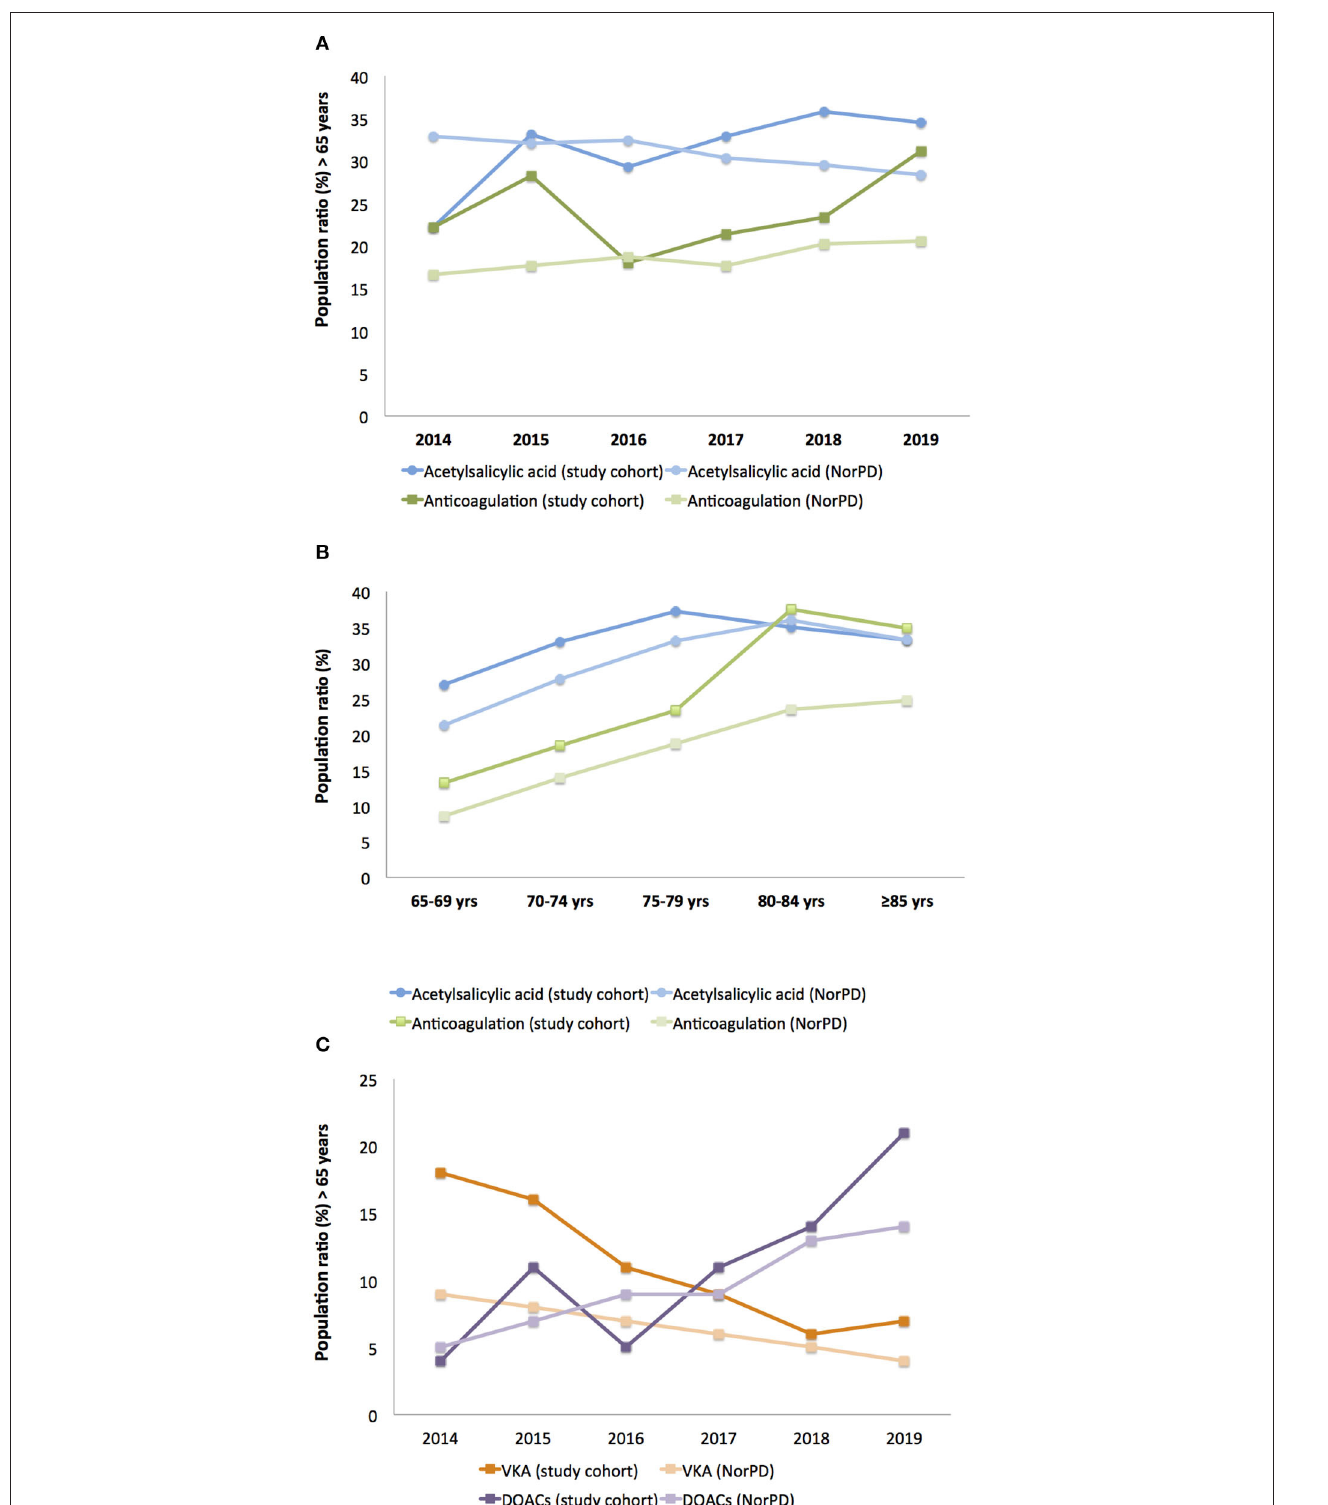
FIGURE 1 | Antithrombotic therapy in study patients compared to the general Norwegian population. (A) Use of acetylsalicylic acid and anticoagulation, (B) use of acetylsalicylic acid and anticoagulation stratified by age groups, (C) use of VKA and DOACs. VKA: Vitamin K antagonists. NorPD: The Norwegian Prescription Database. DOACs: Direct Oral